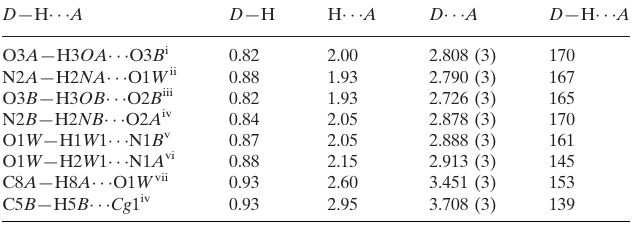
Hydrogen-bond geometry (A˚ , (cid:3) ). Cg 1 is the centroid of C14 A –C19 A benzene